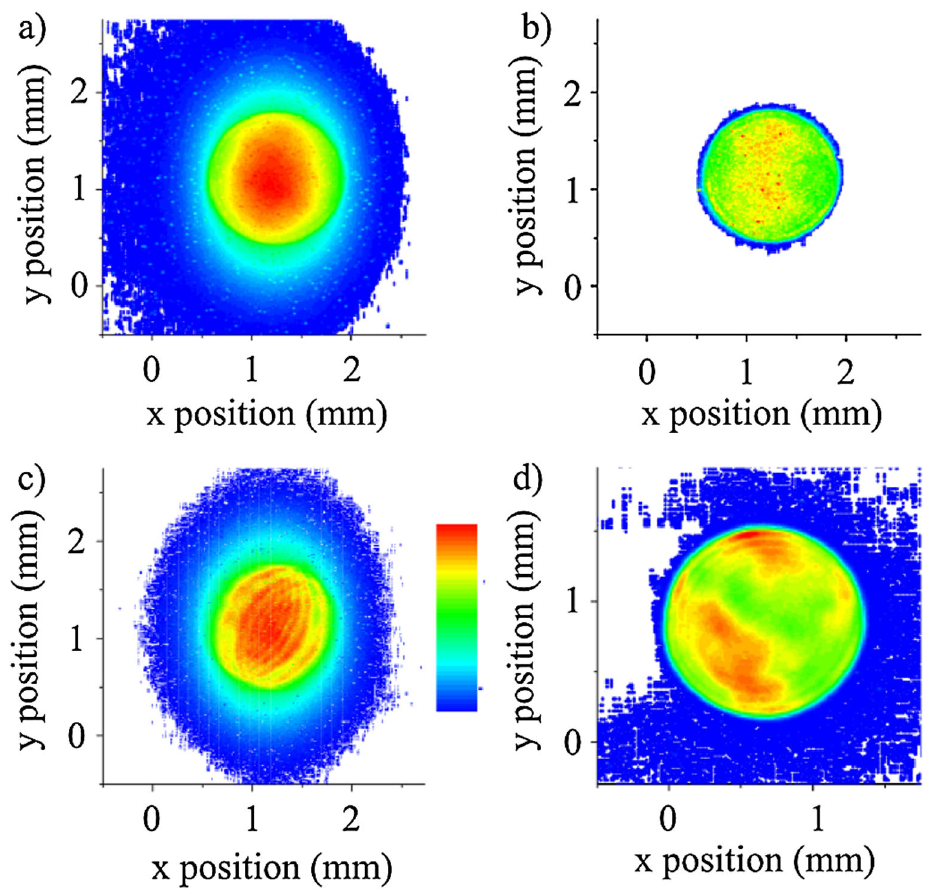
FIG. 7. (Color) (a) Image of the full-energy laser pulse using standard timing. (b) Magnified image of the full-energy laser pulse with fast readout. (c) Image obtained from the quartz-plate beam splitter. (d) Magnified image obtained using the Ce:YAG crystal. In each image, the relative intensity is highest in red, followed by green, blue, and either black or white to represent the zero